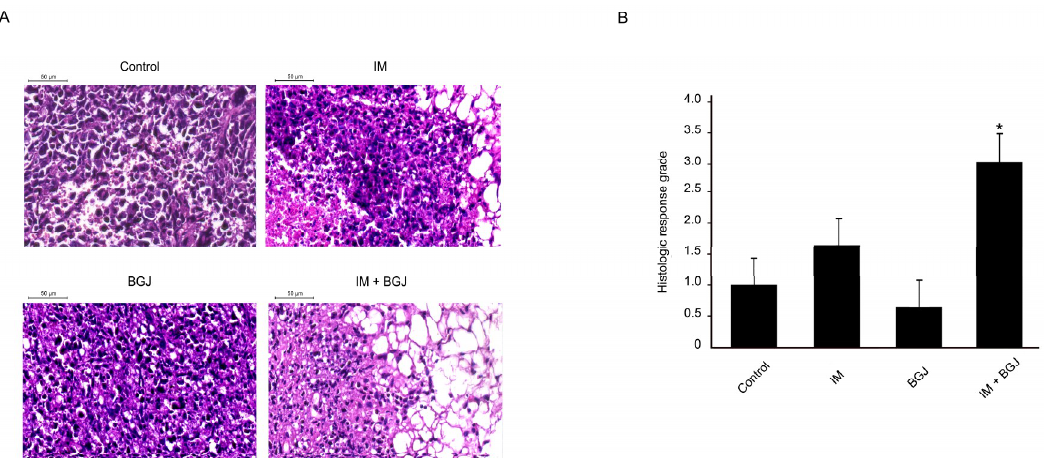
Figure 5. In vivo anti-tumor activity of BGJ38 and IM in a murine GIST xenograft model. ( A ) Histopathologic response (HR) of GIST T-1R xenografts to treatment with IM or BGJ398 used alone or in combination in comparison with a placebo (hematoxylin and eosin, × 10 magnification). ( B ) The data shown in graph represents the average of at least six tumors per group. Columns: mean + SE; * p ≤ 0.05.